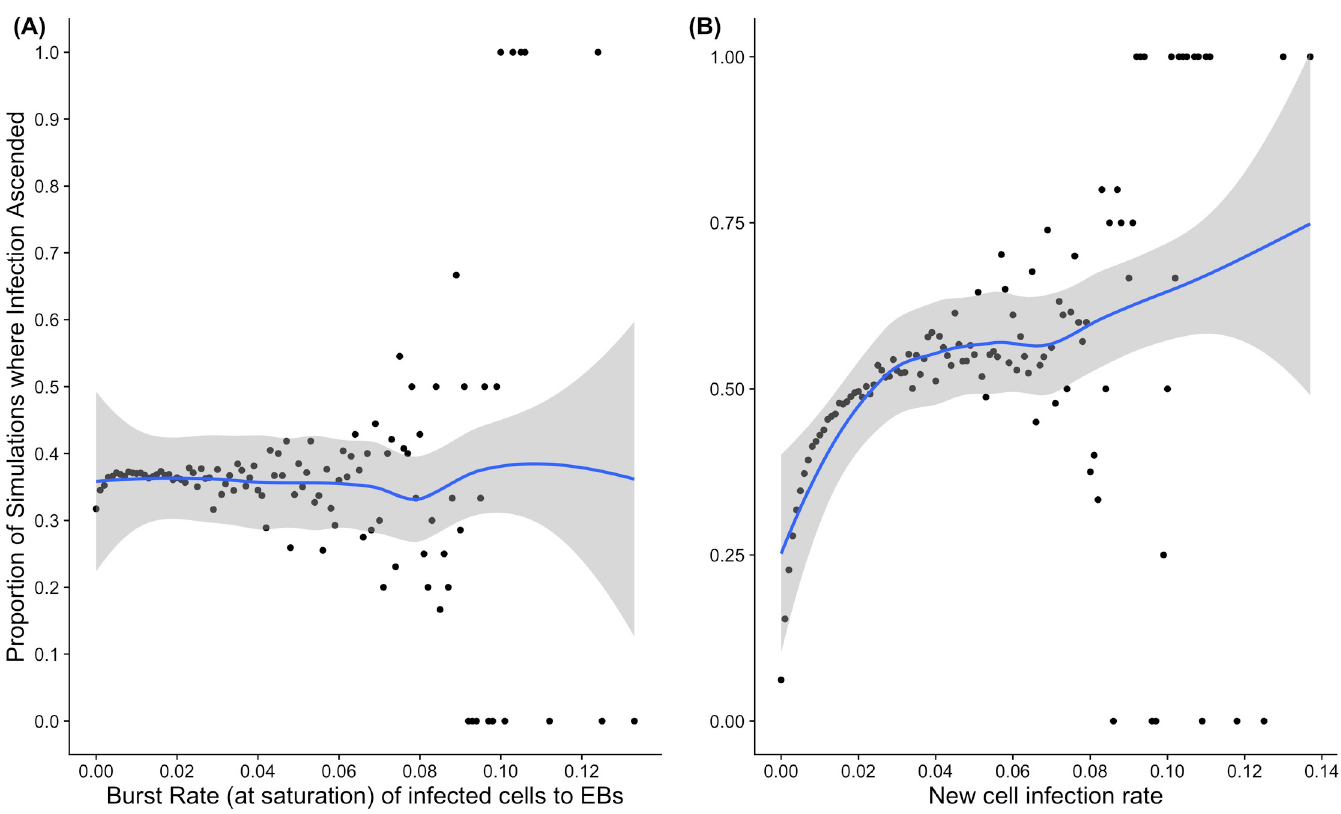
Fig 4. Graphical representation of the proportion of ascension events in the simulations, as influenced by burst rate (A) and new cell infection rate (B).. (A) The relationship between burst rate (in cells per minute) and the simulated chances of ascension. (B) The relationship between new cell infection rate (cells per minute). The y axis shows the proportion of simulations where infections ascended (out of 252, 500 simulations conducted), and x axis shows the different parameters values of burst rate and new cell infection rate). Each dot represents simulations at a particular parameter value. These are simulated over a range of infectious loads (10 simulations at each value of infectious load from 1 to 10001 in steps of 100. The blue line represents a loess fit of ascension proportion against each parameter value, where shading is the 95% confidence interval of the